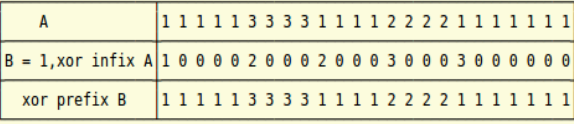
Fig. 4. Using xor infix to convert a full grid line into sparse boundary representation, and xor prefix to go back.